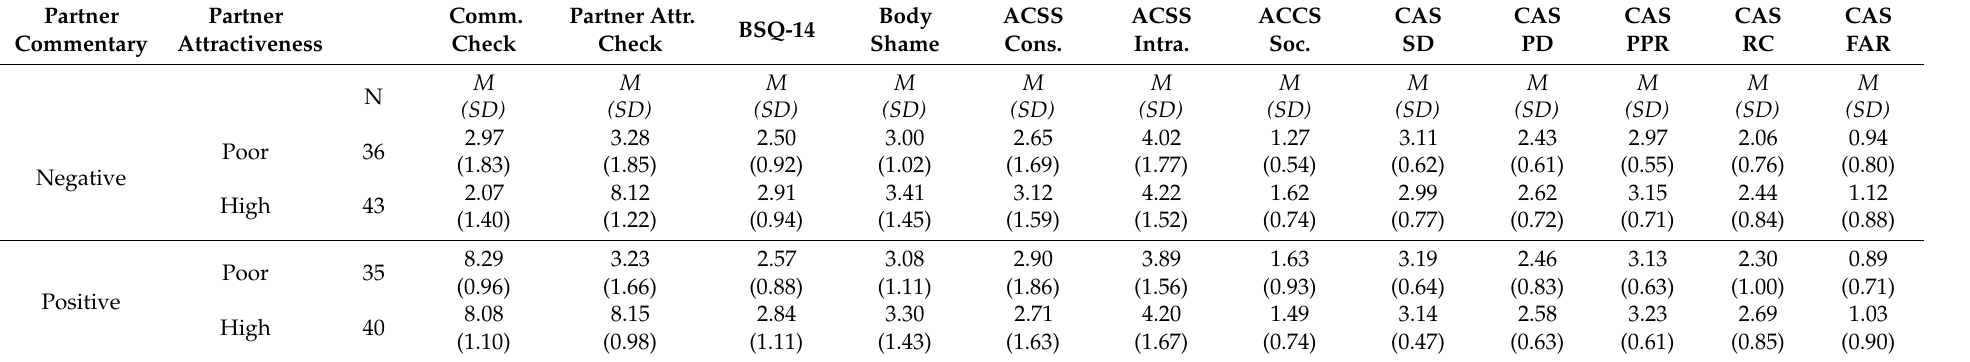
Table 2. Means (SDs) of body dissatisfaction, acceptance of cosmetic surgery, and quality of couple’s relationship by experimental condition